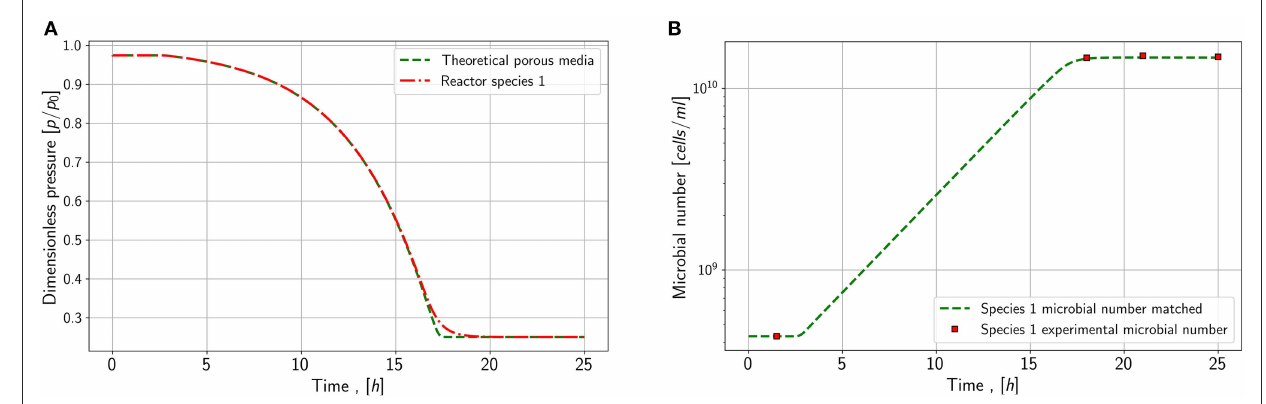
FIGURE8 Simulation results for mass transfer study. (A) Pressure behavior in a closed porous media and a reactor for species 1 (B) Microbial concentration in the reactor and the porous media for species